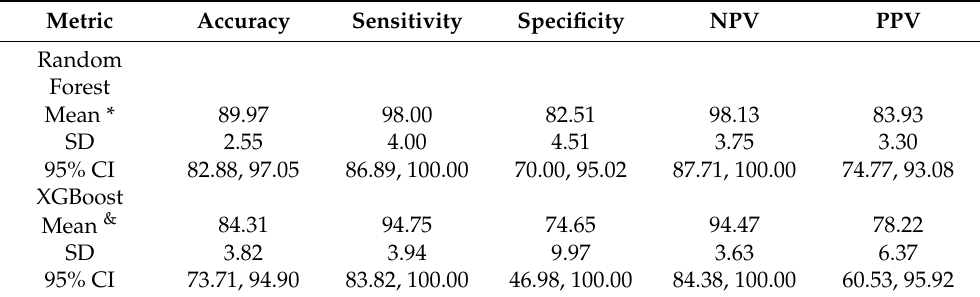
Table 4. Measures of validity in the different evaluations performed in the cross